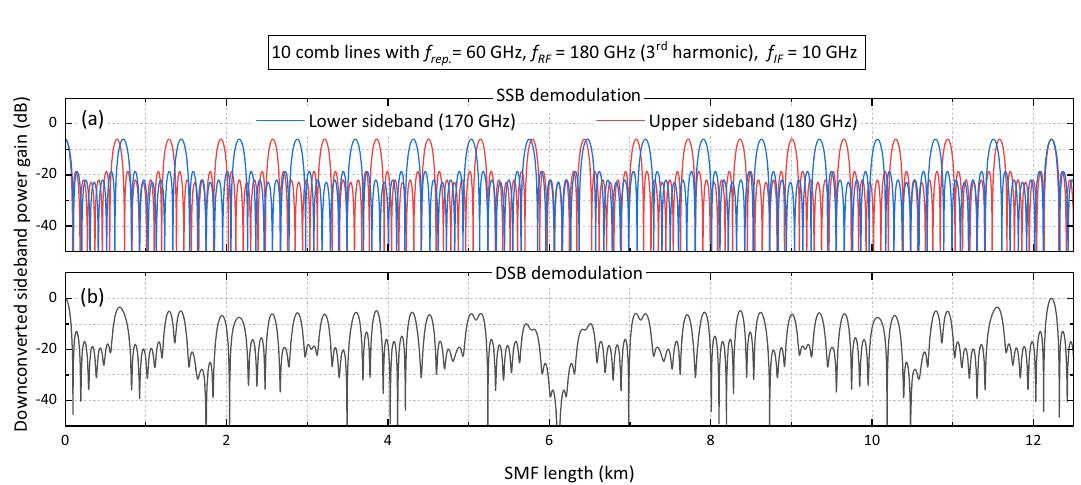
Figure 9. ( a ) Downconverted power gain for the upper and lower sidebands of a 180-GHz DSB-C THz signal generated with an equi-amplitude 10-line comb with a repetition frequency of 60 GHz; ( b ) power gain of the downconverted sideband at f IF = 10GHz when DSB demodulation is employed to recover the 180 GHz